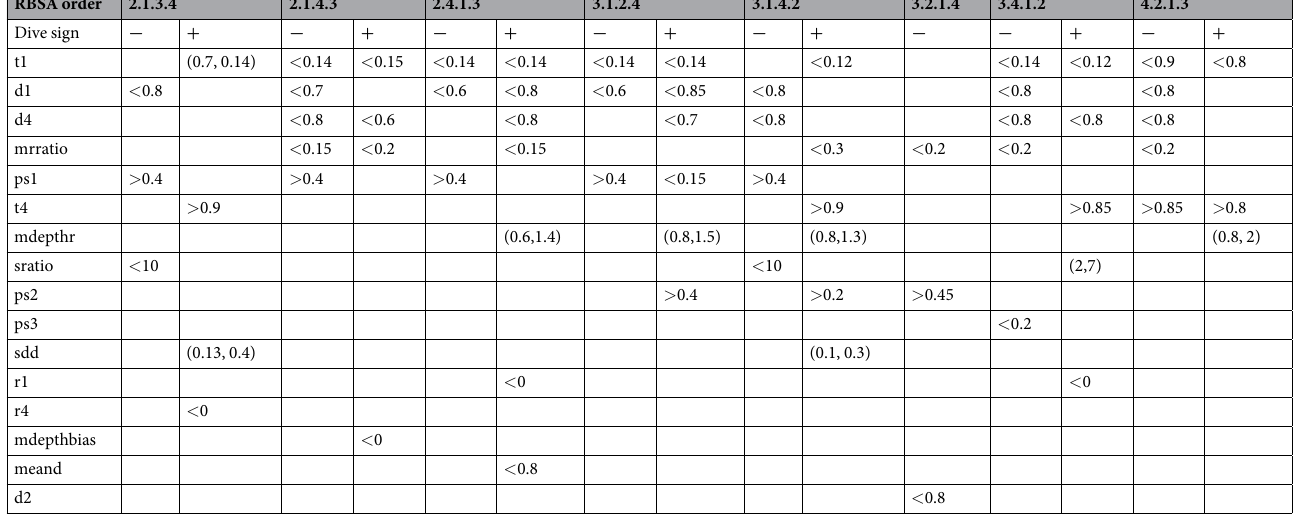
Table 3. Threshold values for dive-based criterion applied to the eight main RBSA groups. Only the cells of the criteria applied contain values. Values in brackets represent the lower (left) and upper (right) open thresholds of the threshold acceptance interval. Dive sign indicates criteria applied to negative ( − ) or positive ( + ) drift dives within groups. For full criteria description see Appendix A. In brief: {d1, d2, d3, d4} = ratio between the depth of the first, second, third and fourth inflection points and the maximum depth. {ps1, ps2, ps3} = proportion of the dive duration spent on the first, second, and third segments generated by the RBSA. sratio = ratio between the vertical rate of the descending phase and the vertical rate of the first segment post-descent. meand = mean value of {d1, d2, d3, d4} described above. sdd = standard deviation of {d1, d2, d3, d4}. {r1, r2, r3, r4} = residuals obtained by fitting a least square linear regression through the four inflection points {D1, D2, D3, D4}. mrratio = ratio between the smallest BSA residual and the maximum depth. mdepthbias = difference between the time at maximum depth and half of the total dive duration. mdepthr: ratio between the averaged depth